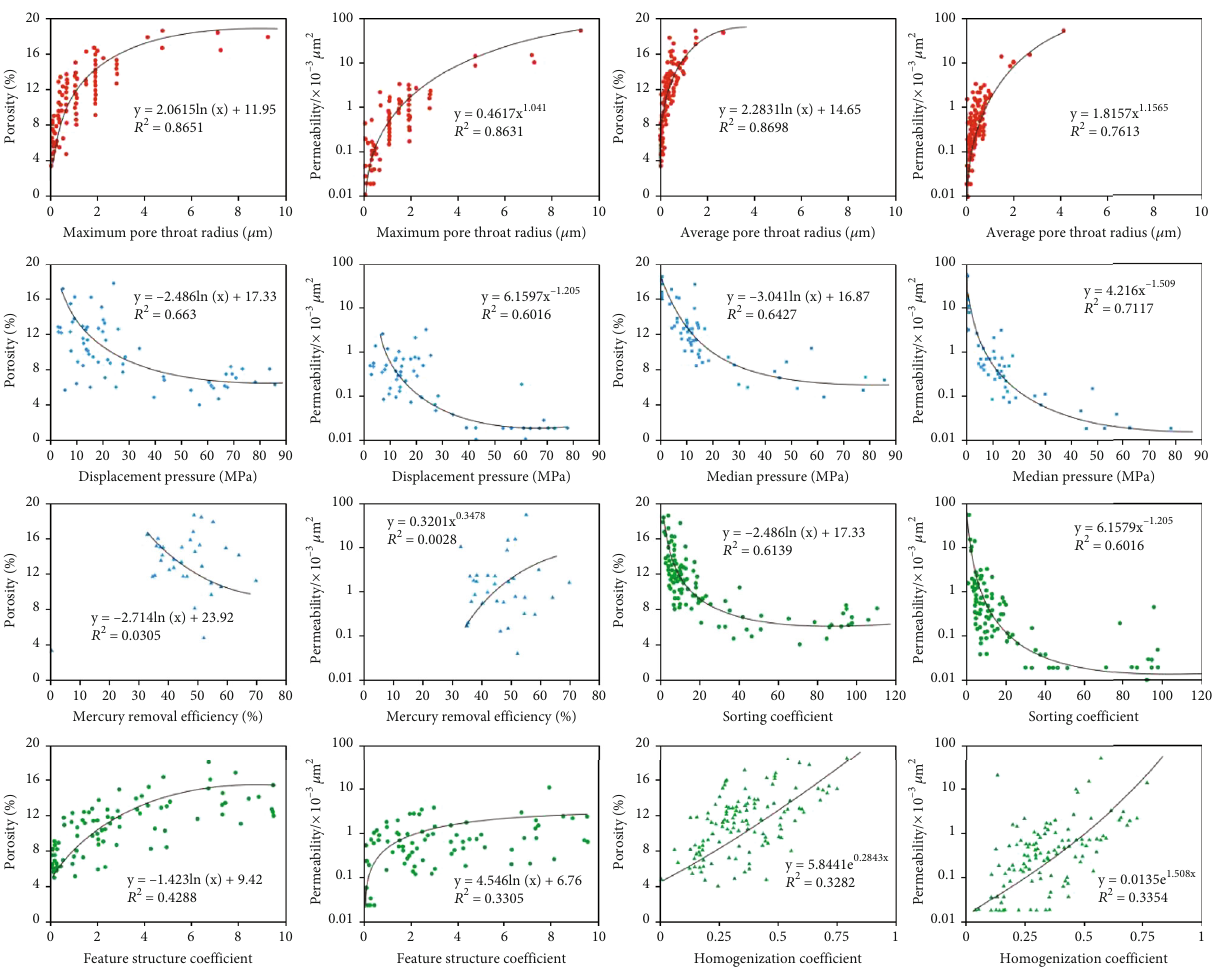
Figure 7: Relationship between structure parameters and reservoir quality.